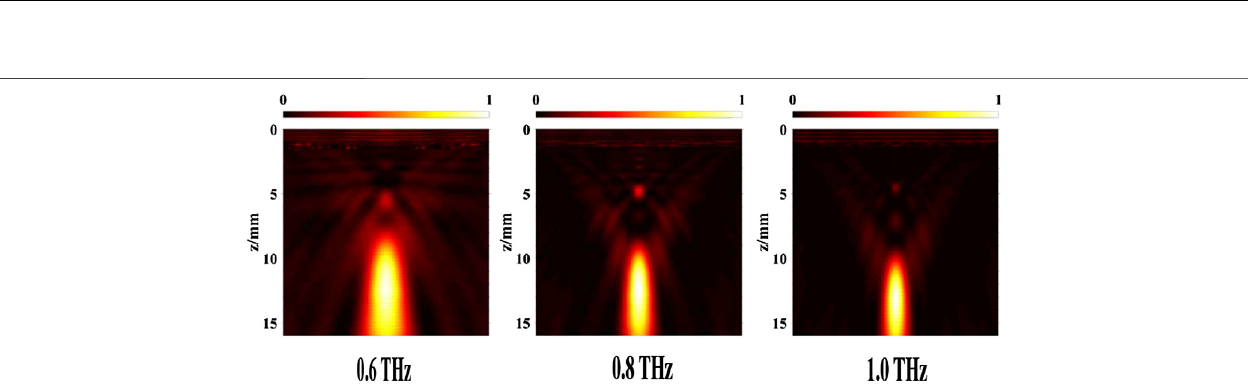
FIGURE 6 | The simulated electric fi eld intensity in the y (cid:2) 0 plane at 0.6, 0.8, and 1.0 THz, respectively.